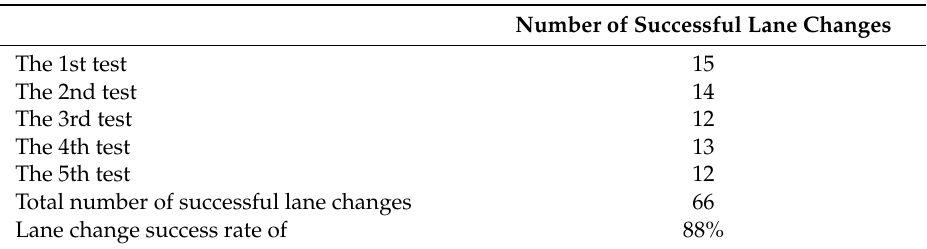
Table 3. Statistics table for successful number of times of lane